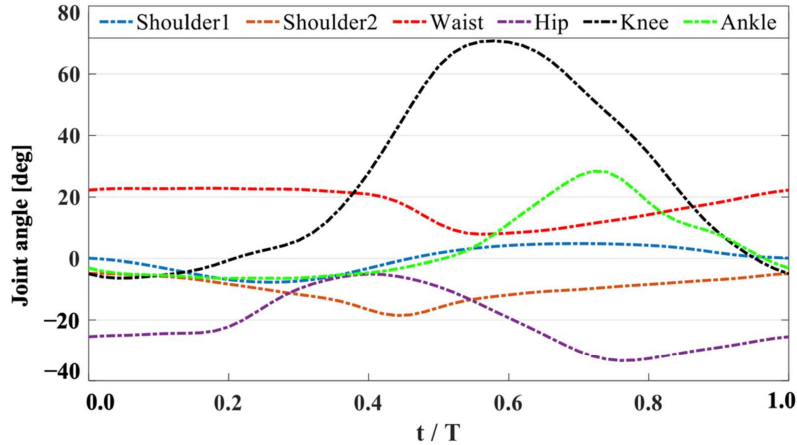
Figure 3. Kinematics of the joints for the UUS of the